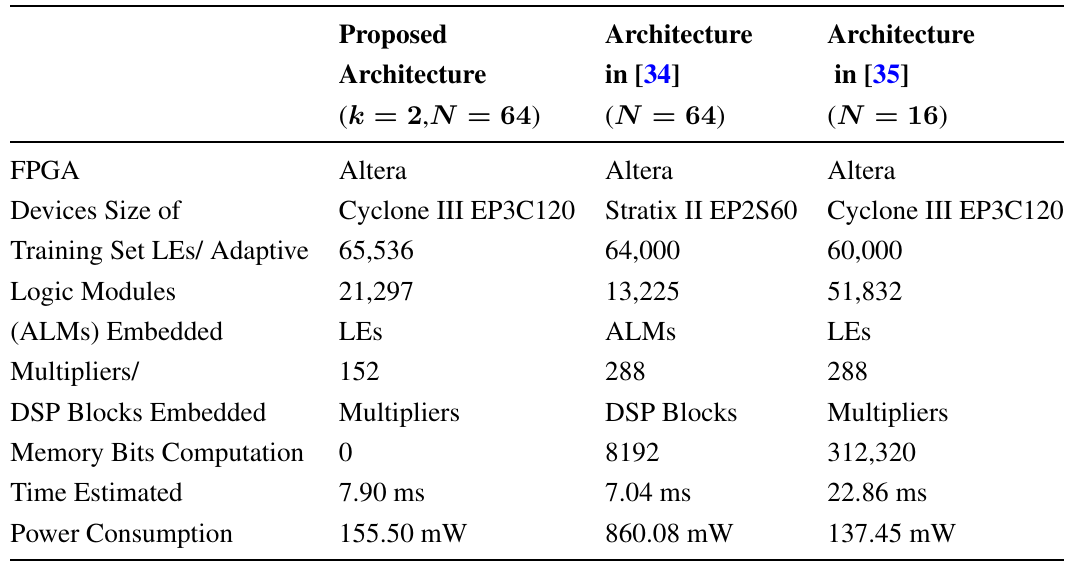
Table 8. Comparisons of various architectures in for clustering applications for dimension w = 2 × 2 .